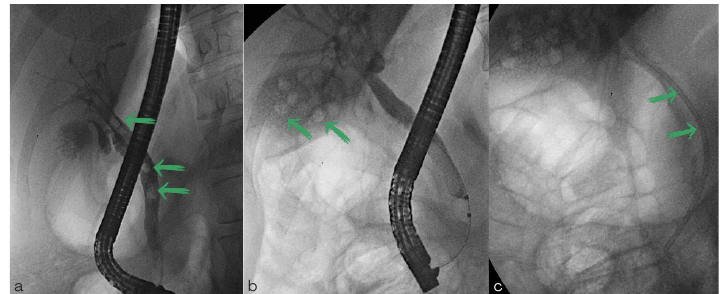
Figure 1. Endoscopic retrograde cholangiopancreatography fluoroscopy images. ( a ) Cannulation of the common bile duct and cholangiogram which shows intraluminal filling defects consistent with stones (green arrows). ( b ) Filling defects in the gallbladder (green arrows). ( c ) Biliary stent deployed (green arrows).